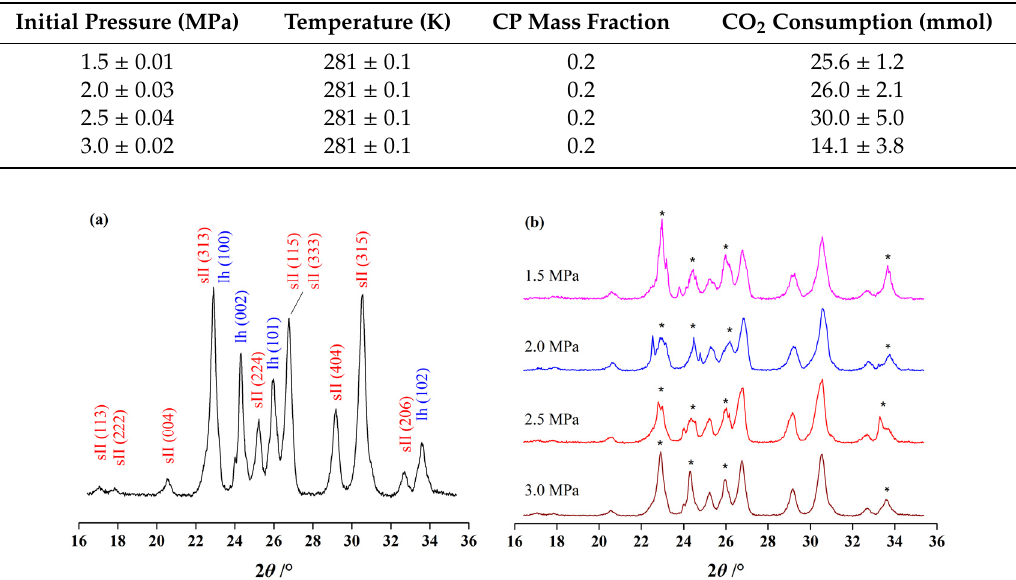
Figure 4. The powder X-ray di ff raction (PXRD) patterns of the hydrate samples formed at 281 K. ( a ) The Bragg peaks of sII hydrate and hexagonal ice; ( b ) the spectra of hydrate formed at di ff erent initial pressure.